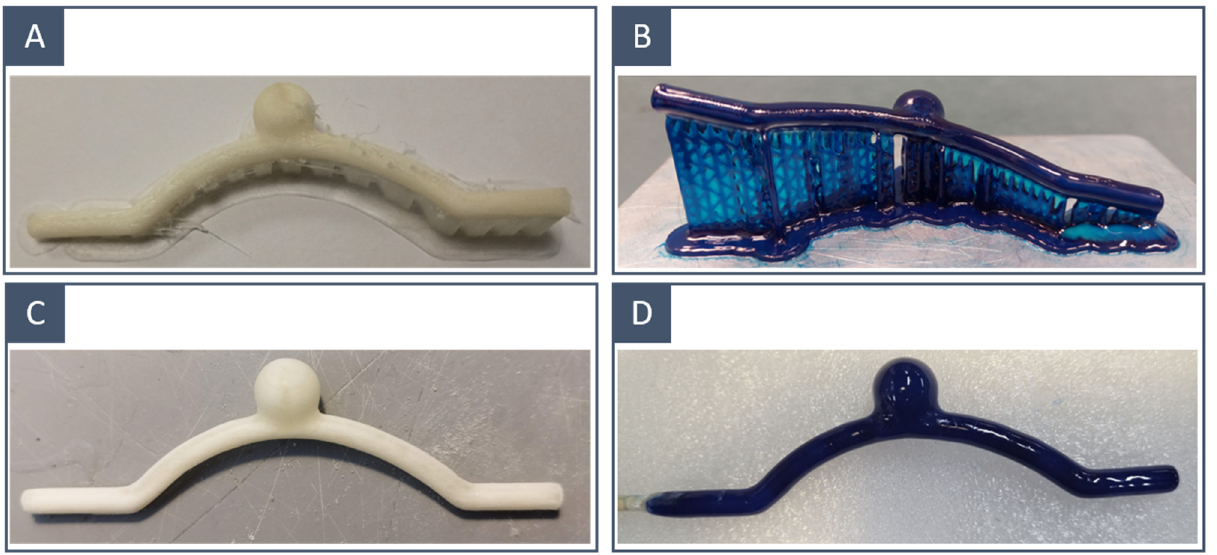
Figure 3. The 3D-printed inner moulds before and after surface treatment: FDM-printed idealised model ( A ) before and ( C ) after postprocessing; SLA-printed idealised model ( B ) before and ( D ) after postprocessing.